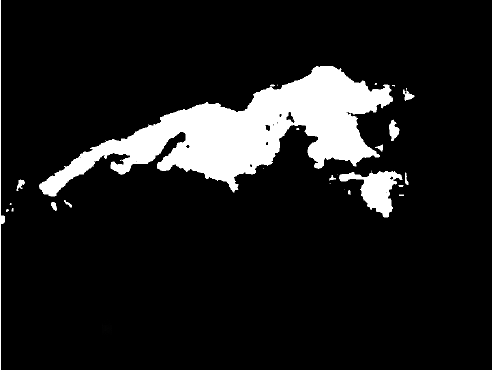
Figure 11. Mask for flow